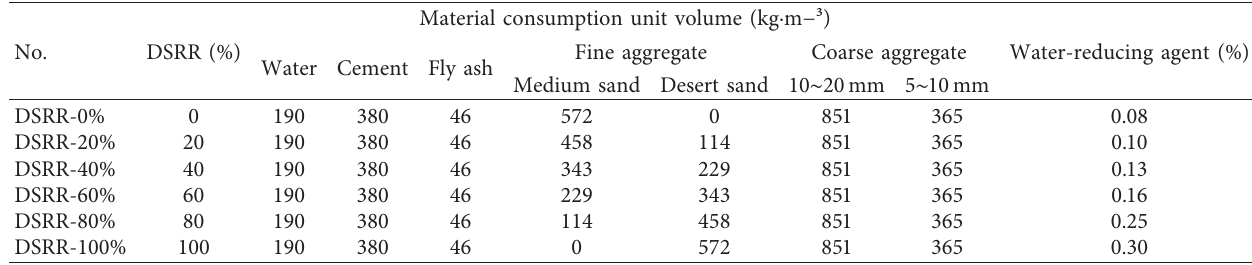
Figure 2: Gradation distribution of raw materials. Table 5: Mix proportion of DSC.